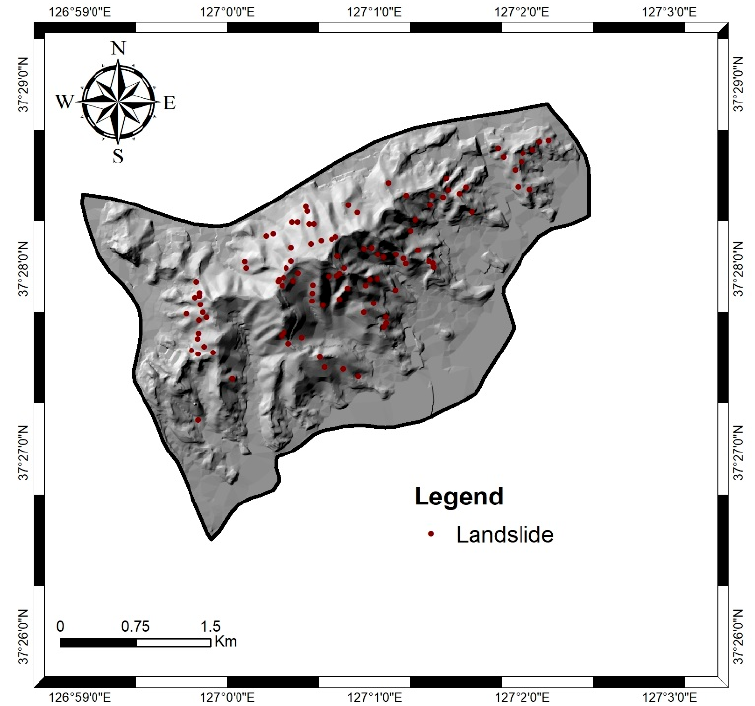
Figure 8. Landslide locations.